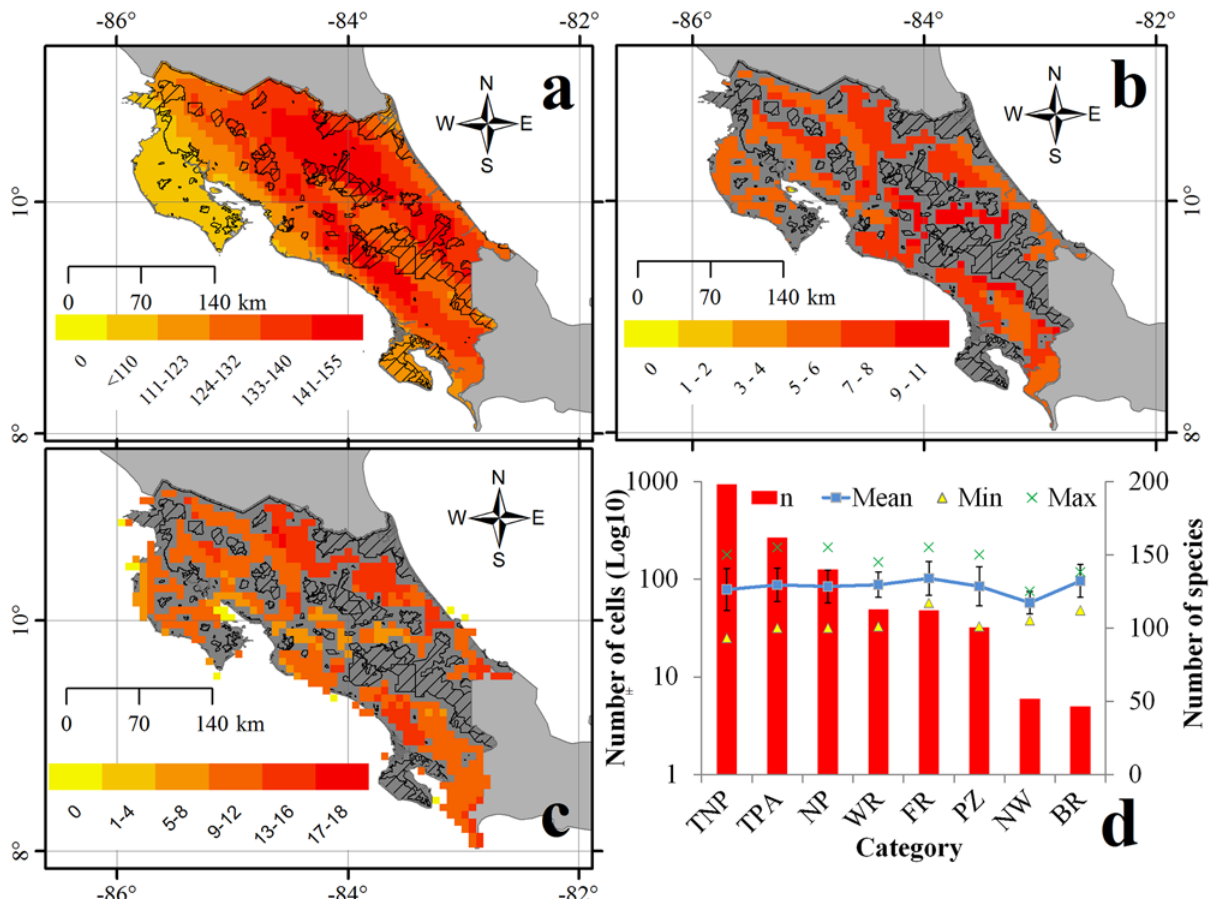
Fig 7. Mammal species richness within 83 km2 grid cells in Costa Rica and protected areas (dashed polygons). a) Total species richness; b) number of threatened (VU, EN, CR and DD) species in cells not covered by protected areas; c) number of underprotected species (according to a priori targets; see Methods) in cells not covered by protected areas, and; d) number of cells not protected (TNP), cells in all protected areas (TPA), and cells on each protected area category (National Parks (NP), Wildlife Refuges (WR), Forest Reserves (FR), Protected Zones (PZ), National Wetlands (NW) and Biological Reserves (BR)). Secondary Y axis indicates the mean (blue line + SD), minimum (triangles) and maximum (x) number of species protected by cell in each